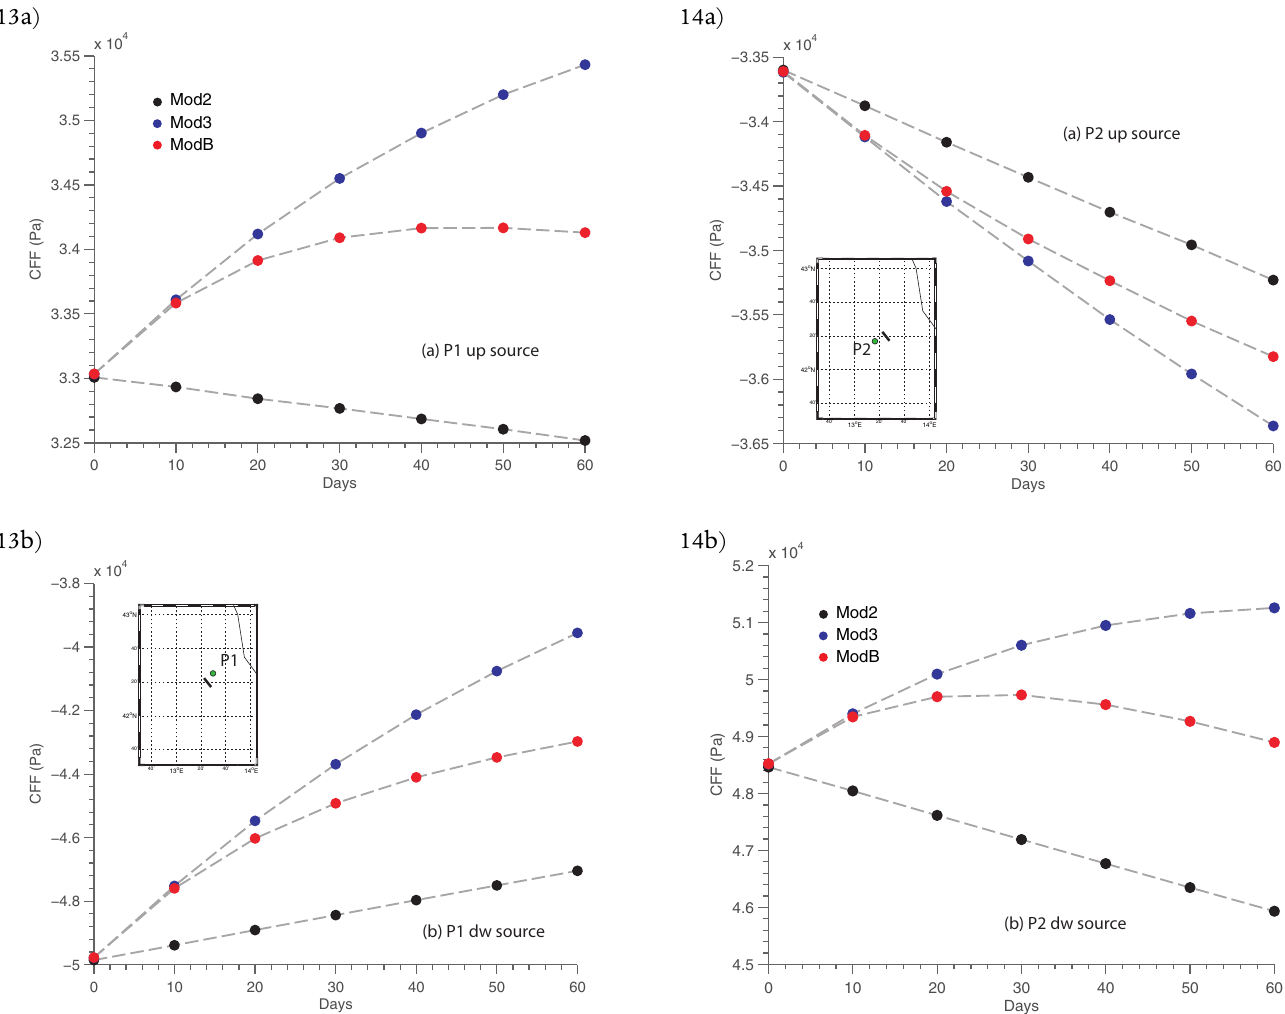
Figure 13. Time histories for the CFF associated with the 2009 L'Aquila earthquake, evaluated at location P1 (green circle in inset), for the different rheological models (as indicated; see Table 2). The observer is located at a depth of 4.46 km (a) and 14.46 km (b). The black line in the inset marks the surface projection of the modeled source. Figure 14. As for Figure 13, evaluated at location